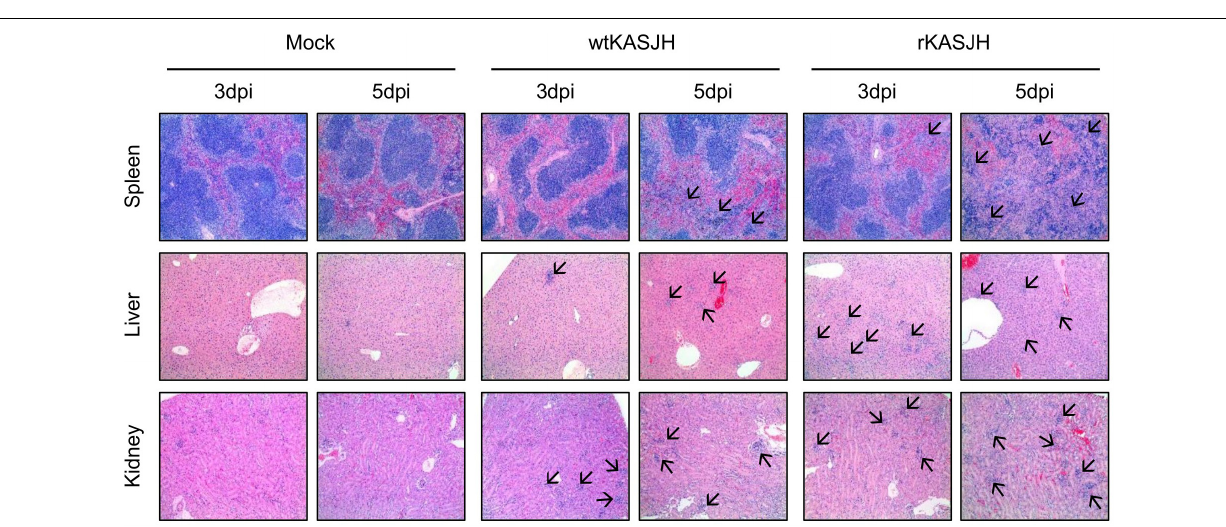
FIGURE 5 | Histopathological analysis of mice infected with parental and rescued SFTSVs. Tissues were harvested at 3 and 5 dpi and processed for H&E staining. Both viruses caused severe lesions that were absent in tissues from mock-infected control mice. Arrows indicate inflamed regions. Magnification, 100 ×